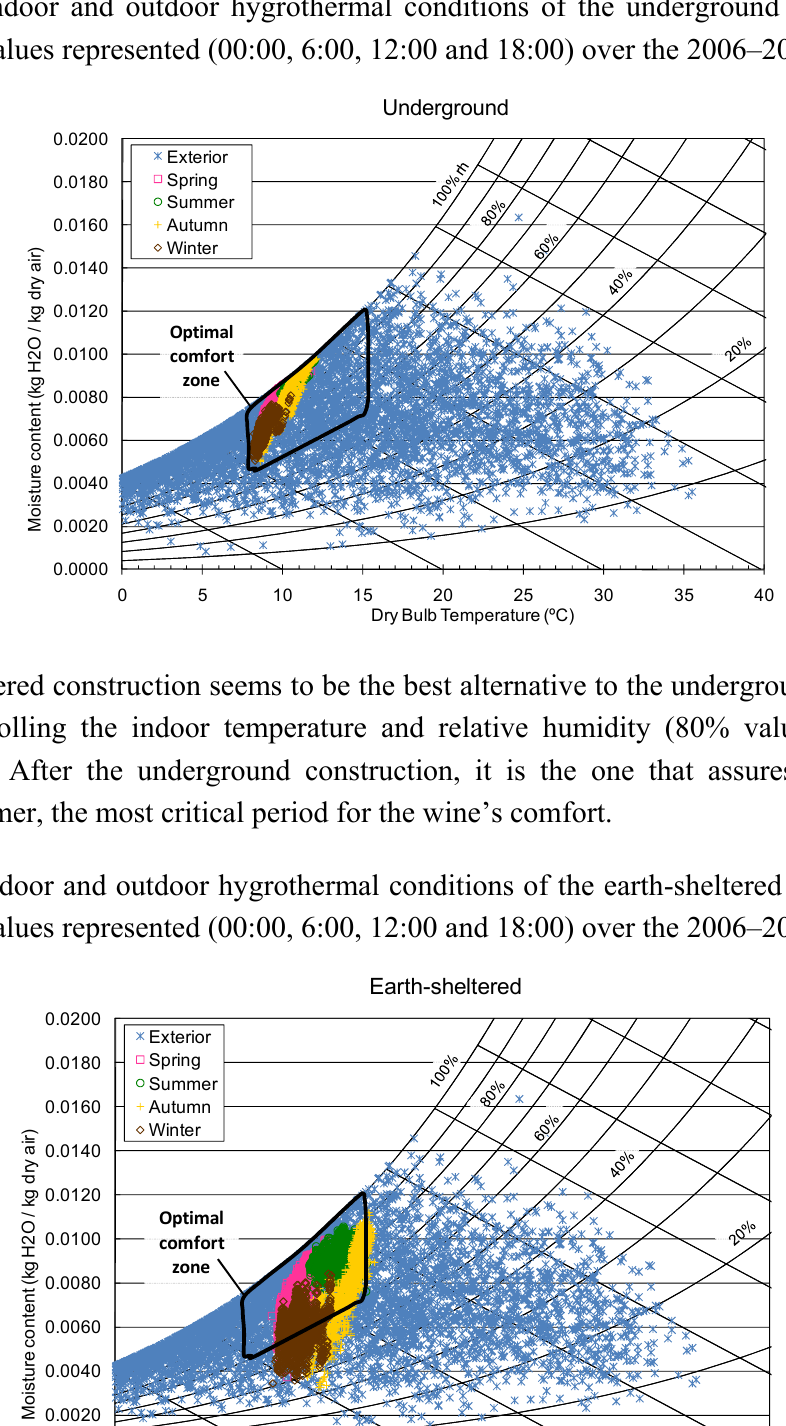
Figure 4. Indoor and outdoor hygrothermal conditions of the underground construction.